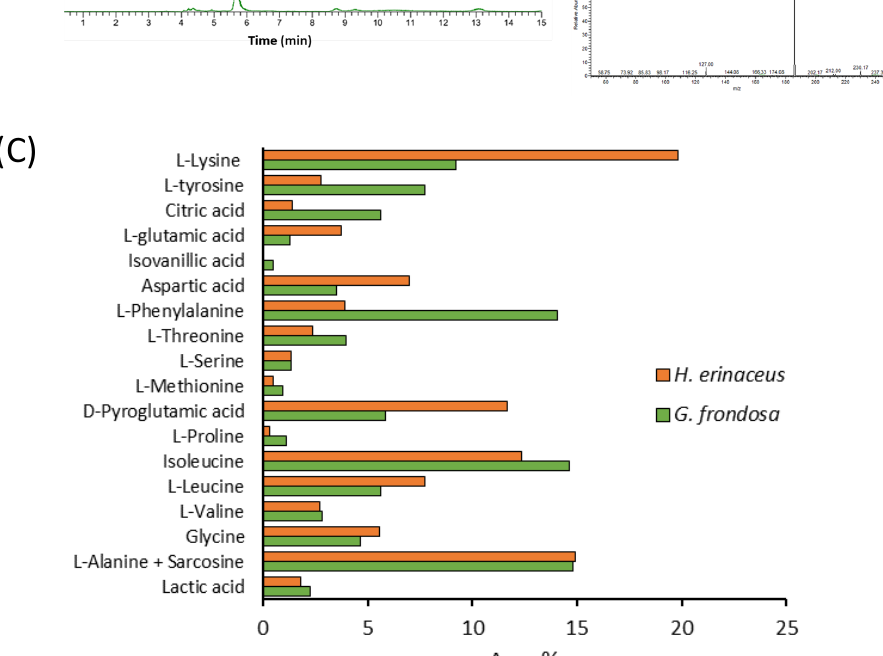
Figure 1. Chemical analysis of fungal extracts ( A ) DTGA curves (left) and FT-IR spectra (right) of the lyophilized aqueous extracts of G. frondosa and H. erinaceus fruiting bodies, and of β -glucan and chitin standards. ( B ) LC/MS (left) and MS/MS spectra of ergothioneine (ET) obtained by fragmentation of the ion at m / z 230 for the aqueous extracts of G. frondosa and H. erinaceus fruiting bodies and an ET standard. ( C ) Relative percentage of metabolites in both G. frondosa and H. erinaceus